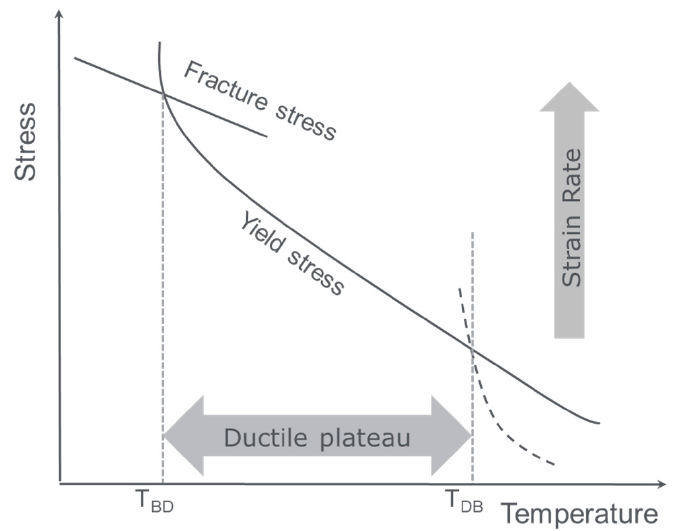
Figure 1. Davidenkov balance between fracture stress, yield stress, and disentanglement craze stress as a function of temperature.